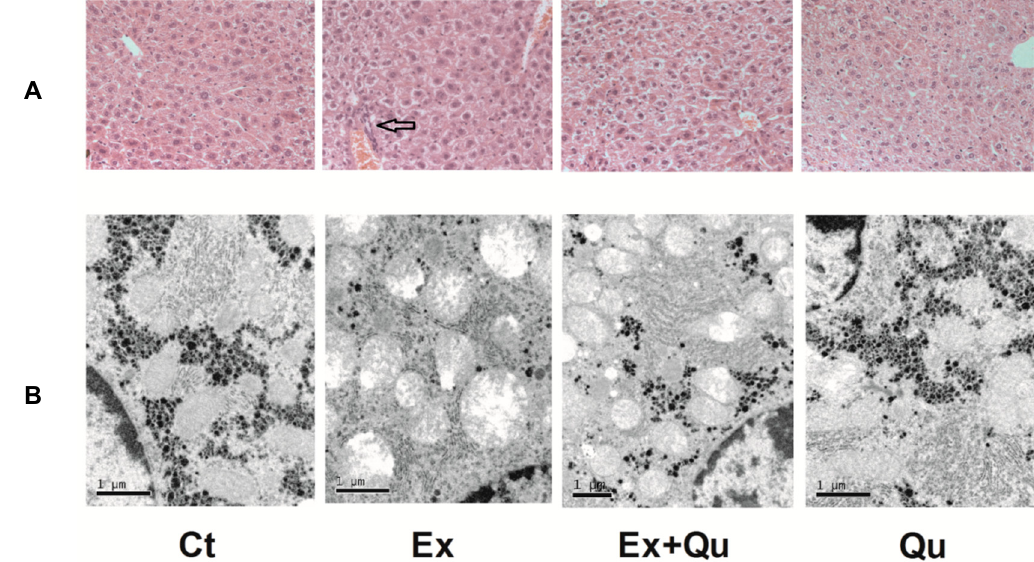
Figure 2. E ff ect of quercetin intervention on liver morphology disturbed by intensive exercise. Liver samples processed by hematoxylin–eosin were observed by Olympus BX50 light microscope with HMIAS-2000 medical imaging system ( × 200) ( A ). The ultrastructure of the liver was shown in a transmission electron microscope (TEM) images ( B ). Ct—rested control; Ex—intensive exercise; Ex + Qu—Ex and quercetin; Qu—rested + quercetin.